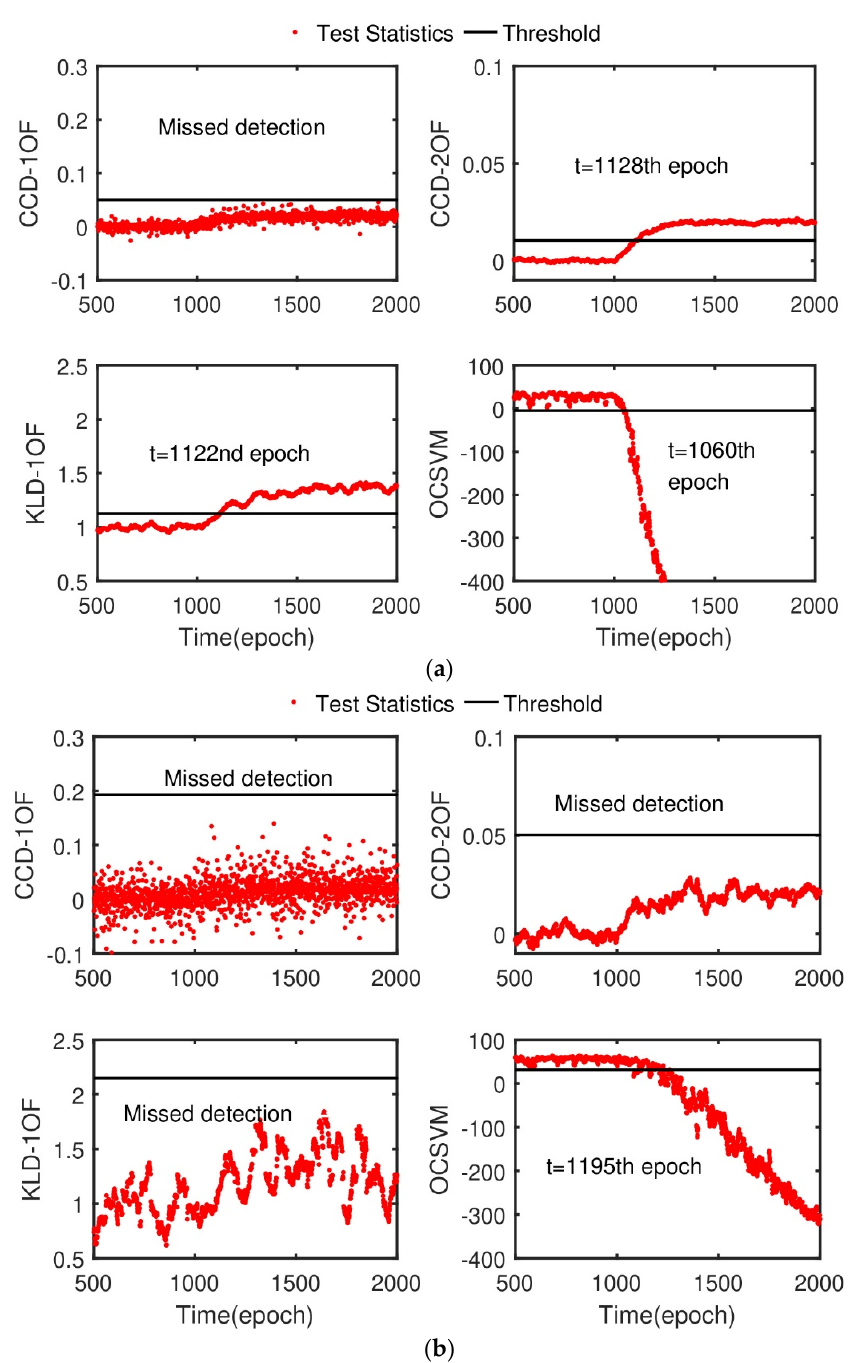
Figure 8. Variation of the test statistics and thresholds of the CCD-1OF, CCD-2OF, KLD-1OF and the proposed OCSVM-based monitors under Laplacian noise, with the noise variance set to 0.5 in ( a ) and 2.5 in ( b ). If the ionospheric anomaly is successfully detected, the detection time is included. Note that the ionospheric anomaly is inserted from the 1000th epoch.